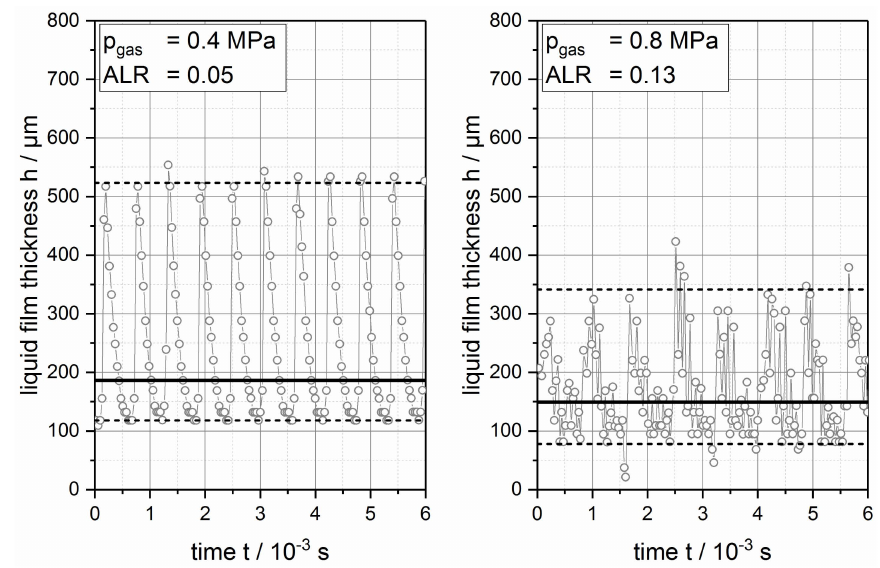
Figure 8. Time dependent simulation results of liquid film thickness h (grey rings) at µ = 0.39 Pa · s and Q L = 40 L · h − 1 . Results at p gas = 0.4 MPa ( left ) and p gas = 0.8 MPa ( right ) are given. Additionally, x 5,0 (lower dashed line), x 50,0 (solid line) and x 95,0 (upper dashed line) of the liquid film thickness are